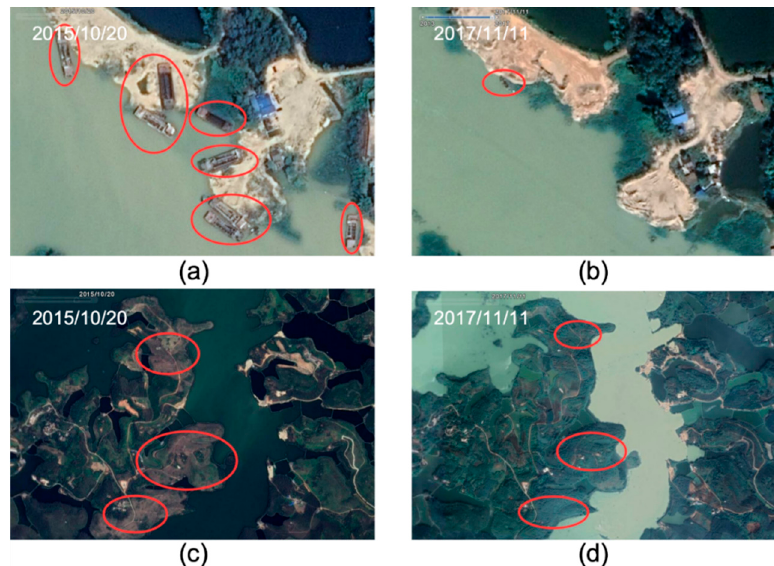
Figure 10. Historical view of the Google Earth image showing the polluted water environment in Hedi Reservior caused by different anthropogenic activities: ( a ) shows the status of large-scale illegal sand mining activities before the river chief system was implemented, ( b ) indicates that sand mining activities are effectively restricted after the execution of the river chief system policy and ( c , d ) depict the extensive area of eucalyptus planting with frequent cutting. All the red circled areas in Figures ( a , b ) indicate changes in sand mining vessels in the same area of the reservoir before and after implementation of the river chief system policy; ( c , d ) reflect the changed progress in eucalyptus planting and cutting.